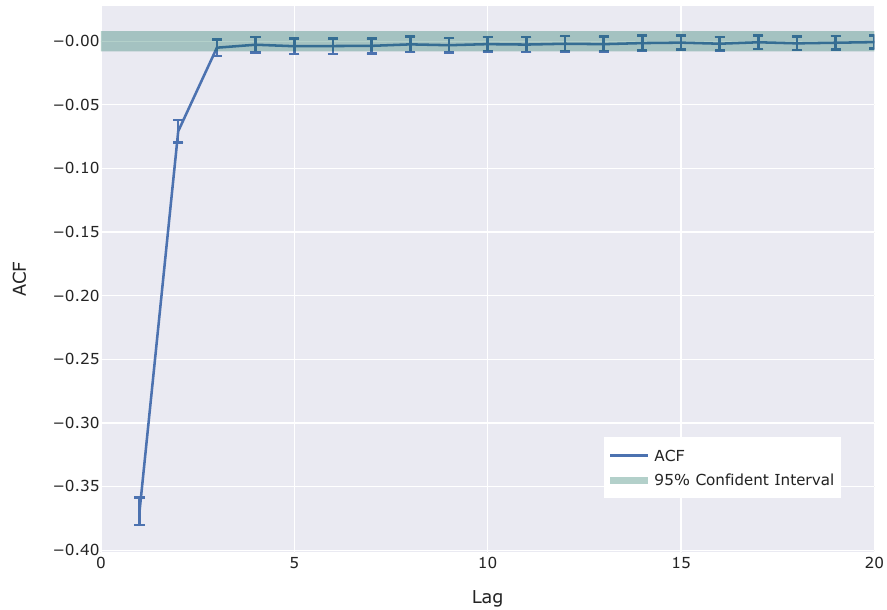
Figure 3. Autocorrelation function (ACF) for logarithm returns. Error bars mean standard deviation for each lag among 500 markets in 100 simulations. The green area shows the 95% confident interval corresponding to each